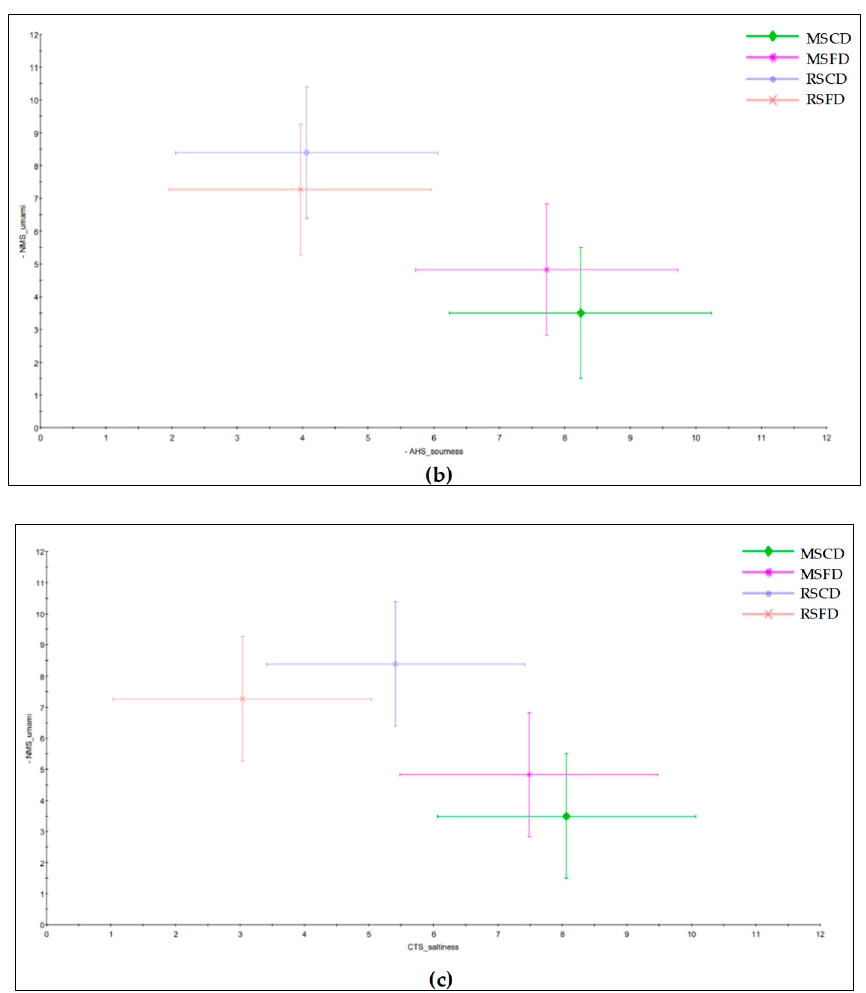
Figure 2. The fingerprint of E—tongue data (( a ) saltiness/sourness; ( b ) umami/sourness; ( c ) umami/saltiness) for exotic fruit seed powders obtained by FD and CD drying methods; MSCD— convectionally dried mango seed powder; MSFD—freeze-dried mango seed powder; RSCD—convectionally dried rambutan seed powder; RSFD—freeze-dried rambutan seed powder.